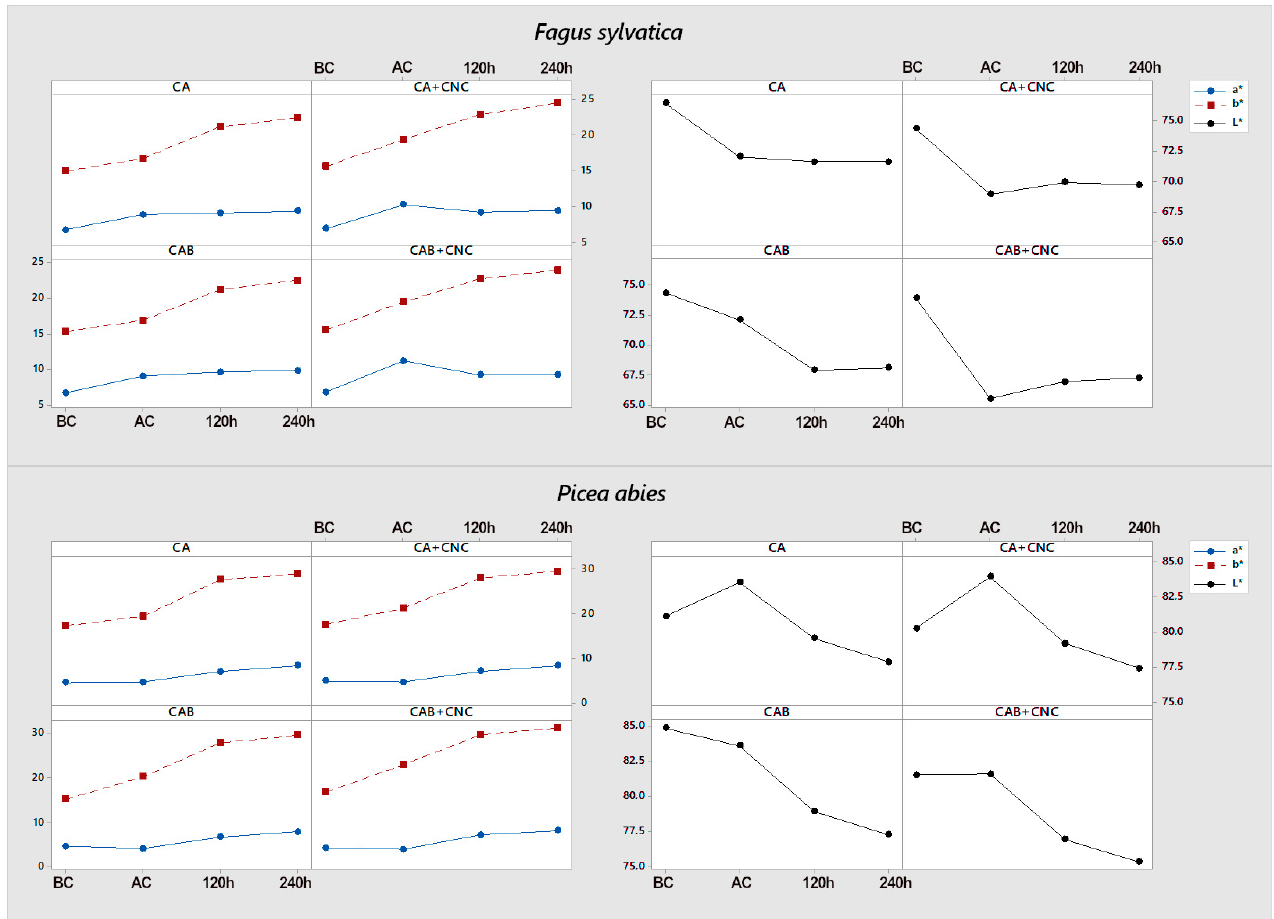
Figure 4. Color analysis results. a* (red-green) and b* (blue-yellow) coordinates on the left and L* (lightness) coordinate in the right for F. sylvestris and P. abies . BC: Before coating. AC: After coating. 120h: After xenon exposure for 120 h. 240h: After xenon exposure for 240 h. CA: Commercial acrylic waterborne coating. CA+CNC: CA with addition of 2% CNC gel. CAB: Commercial acrylic waterborne coating with biocides. CAB+CNC: CAB with addition of 2% CNC gel. Table 4. Color difference results. BC: Before coating. AC: After coating. 120h: After xenon exposure for 120 h. 240h: After xenon exposure for 240 h. Control: uncoated wood, as control for artificial weathering (AW).